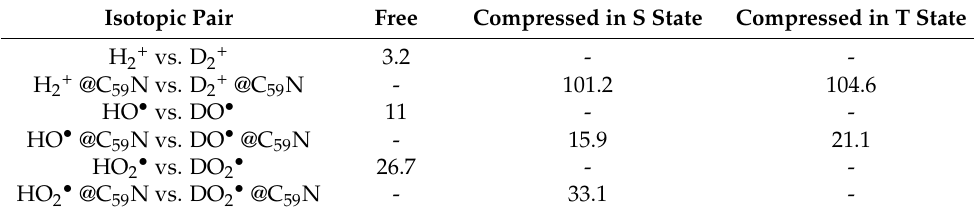
Table 2. Deuterium isotope effects on free and compressed molecules. Isotopic Pair